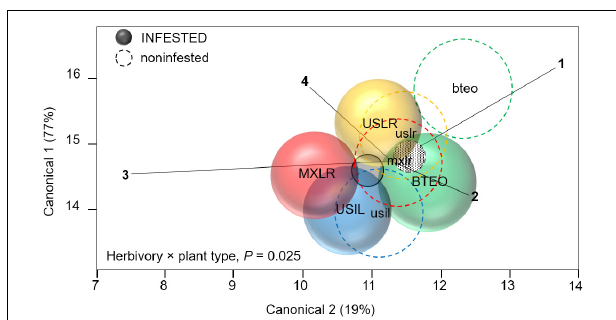
FIGURE 4 | Canonical centroid plot for multivariate analysis of variance (MANOVA) on plant variables associated with plant tolerance to feeding by Western corn rootworm; circles represent 95% confidence intervals around multivariate means for each plant type. The model includes the independent variables ‘plant type’ (Balsas teosintes, Mexican maize landraces, US maize landraces, US inbred maize lines), ‘accessions’ nested within plant type (three accessions per plant type, not shown here), herbivory (Western corn rootworm presence or absence) and the interaction term ‘herbivory × plant type.’ The dependent variables were foliar weight (ray 1), leaf surface area (2), final stem diameter (3), and root weight (4). The overall model (Wilks’ λ = 0.142, P < 0.001) and main effects were significant: plant type ( λ = 0.622, P < 0.001), herbivory ( F 4 , 164 = 16.555 P < 0.001), and herbivory × plant type ( λ = 0.869, P = 0.025). Pair-wise comparisons between Western corn rootworm-infested and -non-infested plants within plant types (depicted by continuous circles/upper-text and dashed circles/lower-case text) were significant for all plant types, except for US landraces (red circles): Balsas teosintes, F 4 , 164 = 9.922, P < 0.001; Mexican landraces, F 4 , 164 = 4.115, P = 0.003; US landraces. F 4 , 164 = 2.253, P = 0.065; US inbred lines, F 4 , 164 = 4.684, P = 0.001. Smallest circles (filled) near plot center represent overall Western corn rootworm-infested (solid line and filling) and -non-infested (dashed line, patterned filling) plants. BTEO, bteo, Balsas teosintes infested or non-infested, respectively, by Western corn rootworm; MXLR, mxlr, Mexican landraces; USLR, uslr, US landraces; USIL, usil, US inbred lines.